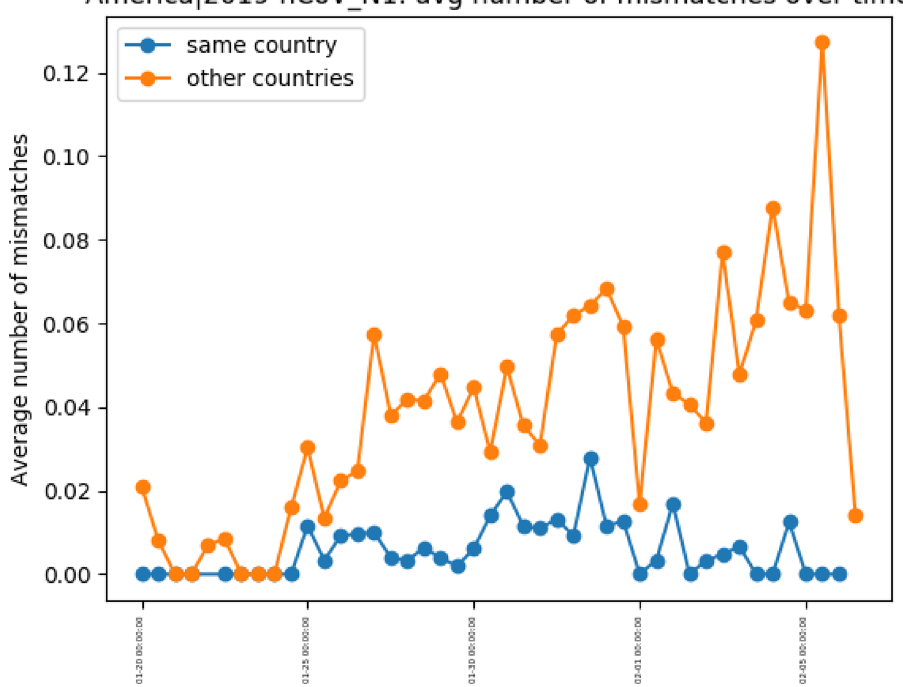
Figure 6. Number of mismatches in and out of country for an American nucleoprotein primer separated by time of genome collection. All other primers are included in the